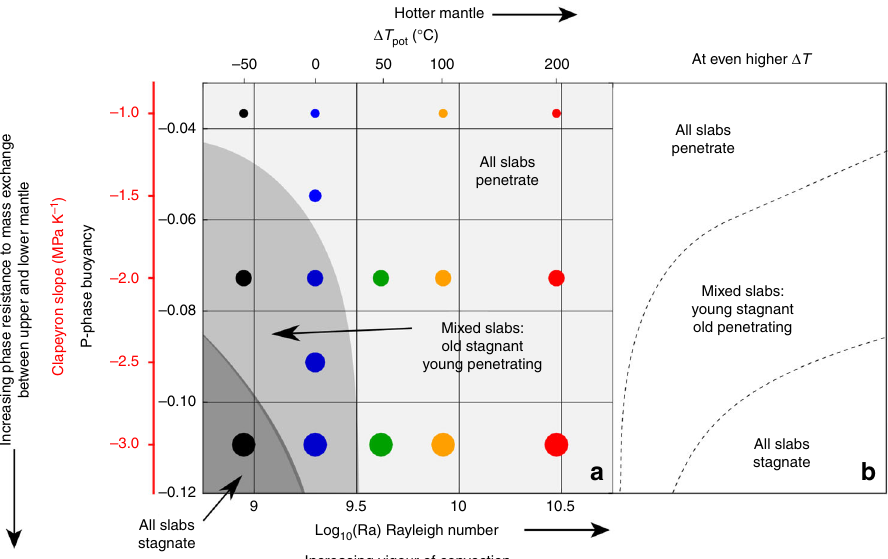
Fig. 4 Mantle mixing modes at different mantle temperatures. Regime diagram obtained from all our simulations (coloured dots) as a function of the phase buoyancy number P (and corresponding Clapeyron slope) for the endothermic phase transition and Rayleigh number (and corresponding mantle temperature). Note that the Ra of our regional models are not directly comparable to those of the global-scale models in Fig. 1b, but present-day Earth conditions are likely somewhere around the middle blue dot. Dark grey fi eld covers the domain of pure slab stagnation, middle grey the domain for young slab penetration and old slab stagnation, light grey fi eld the domain of pure slab penetration. On the right side, the regime diagram is schematically extended as expected at even higher temperature from the results of our weak slabs models together with results from previous models where plates were weak and trenches less